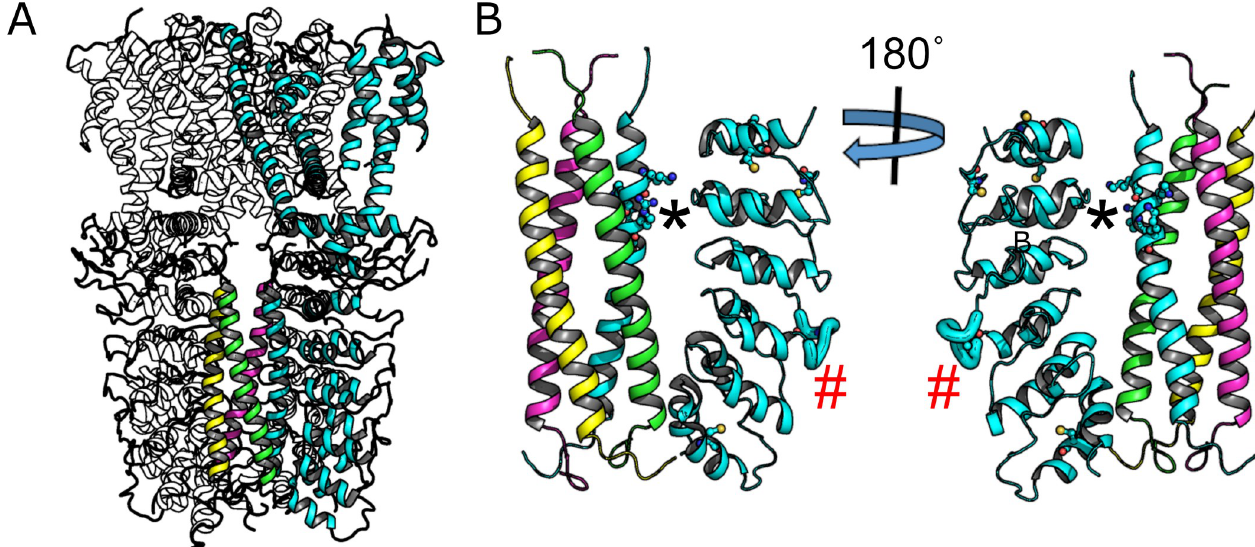
Fig 1. Structural features of human TRPA1. (A) Cartoon structure of human TRPA1 (3J9P) with one subunit highlighted in cyan. The C-terminal coiled-coil helices of all subunits are also shown in color. (B) The cytoplasmic domains showing the resolvable N-terminal ankyrin repeat domains of one subunit along with the coiled-coil. Ball-and-sticks on the coiled-coil helix are positively charged amino acids predicted to destabilize formation of the coiled-coil tetramer. Cysteine residues on the ankryin repeat domains are also shown as ball-and-sticks. The asterisk indicates proposed IP 6 binding site and the red pound sign indicates the region increased proteolysis upon activation by the electrophilic compound NMM as determined by Samanta et al[14].